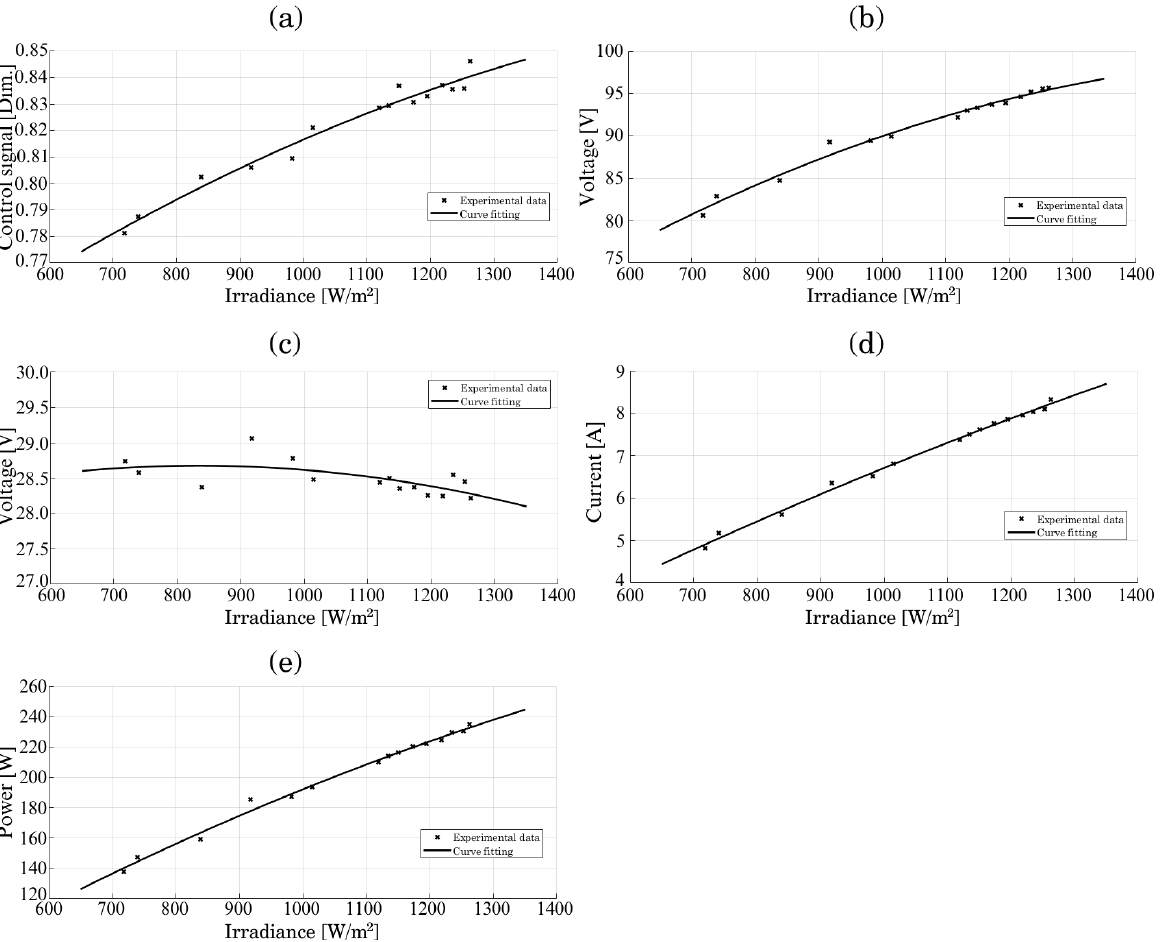
Figure 20. PV system variables behavioral in the MPP: ( a ) P&O algorithm signal control, ( b ) DC bus voltage, ( c ) PV cells voltage, ( d ) PV cells current, and ( e ) PV cells power.